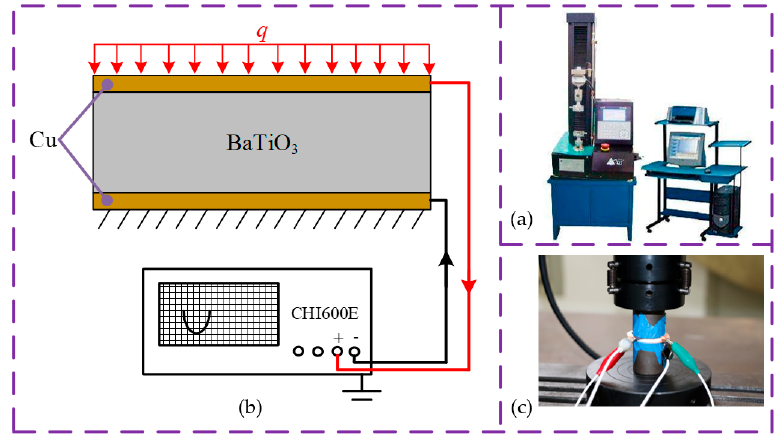
Figure 10. System diagram of the ceramic static pressure test: ( a ) hydrostatic machine; ( b ) ceramic static pressure diagram; ( c ) ceramic static pressure experiment.